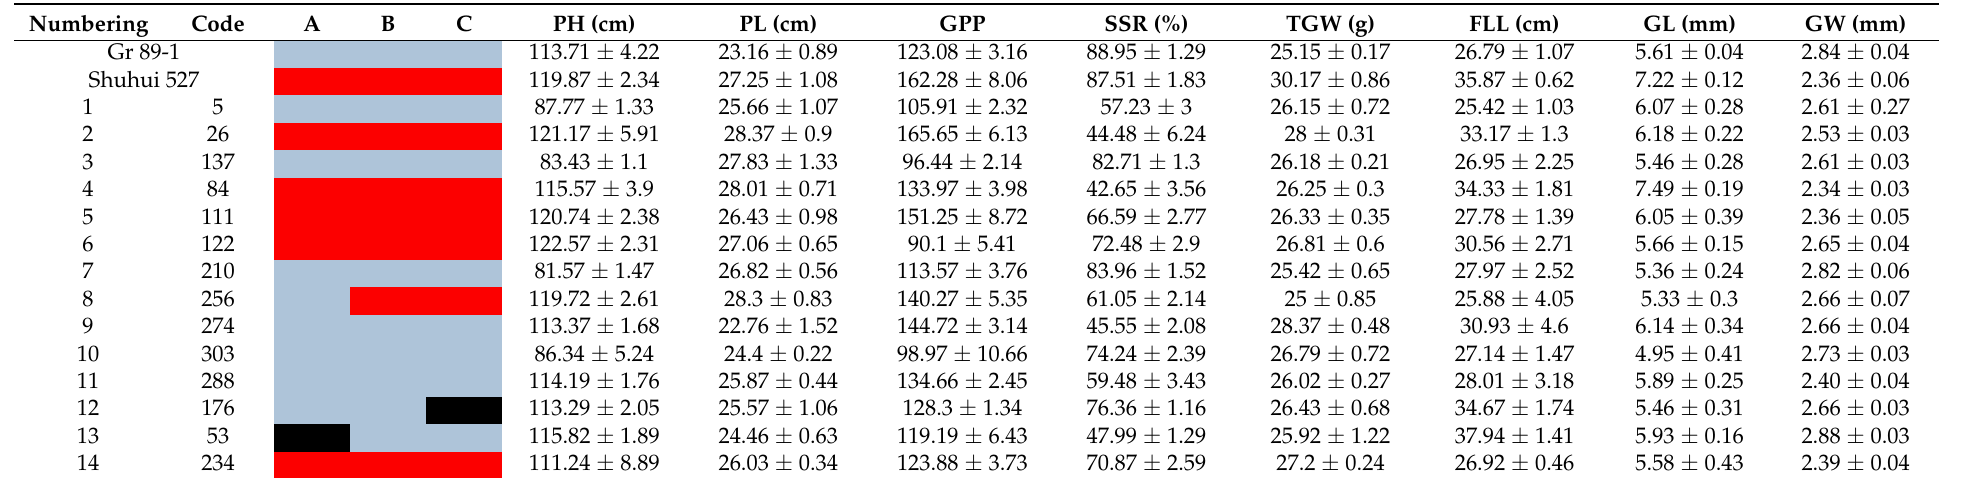
Table 2. Phenotypes of 14 different lines.